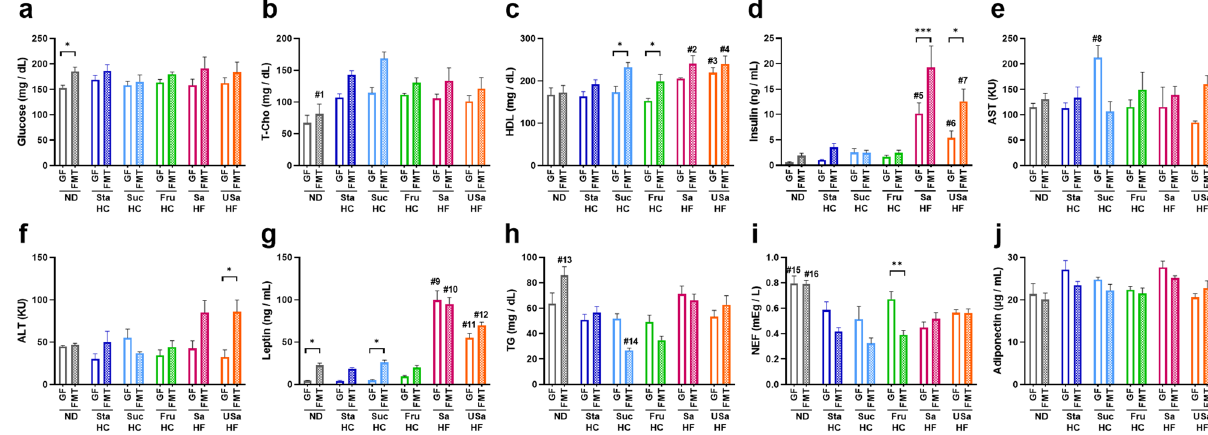
Figure 4. Differences in metabolic parameters of the plasma between germ-free (GF) and fecal microbiota- transplant (FMT) mice fed six different diets. ( a ) Glucose, ( b ) T-Cho, ( c ) HDL, ( d ) insulin, ( e ) AST, ( f ) ALT, ( g ) leptin, ( h ) TG, ( i ) NEF, and ( j ) adiponectin. Values are presented as the mean + SEM (n = 4–7). Asterisks (*) indicate significant differences between GF and FMT (* p < 0.05, ** p < 0.01, and *** p < 0.001), and the # denotes the following significances between the diet groups by two-way analysis of variance, followed by Tukey’s test: #1 ND vs StaHC ( p = 0.001), vs SucHC ( p < 0.0001), vs FruHC ( p = 0.019); #2 ND vs SaHF ( p = 0.031); #3 FruHC vs USaHF ( p = 0.013); #4 ND vs USaHF ( p = 0.034); #5 vs SaHF vs ND ( p < 0.0001), vs StaHC ( p = 0.0001), vs SucHC ( p = 0.009), vs FruHC ( p = 0.0003); #6 SaHF vs USaHF ( p = 0.042), vs ND, StaHC, SucHC, and FruHC ( p < 0.0001); #7 USaHF vs SaHF ( p = 0.042), vs ND, StaHC, SucHC, and FruHC ( p < 0.0001); #8 StaHC vs USaHF ( p = 0.033); #9 SaHF vs USaHF, ND, StaHC, SucHC, and FruHC ( p < 0.0001); #10 SaHF vs USaHF ( p = 0.006), vs ND, StaHC, SucHC, and FruHC ( p < 0.0001); #11 USaHF vs SaHF, ND, StaHC, SucHC, and FruHC ( p < 0.0001); #12 USaHF vs SaHF ( p = 0.006), vs ND, StaHC, SucHC, and FruHC ( p < 0.0001); #13 ND vs StaHC ( p = 0.027),